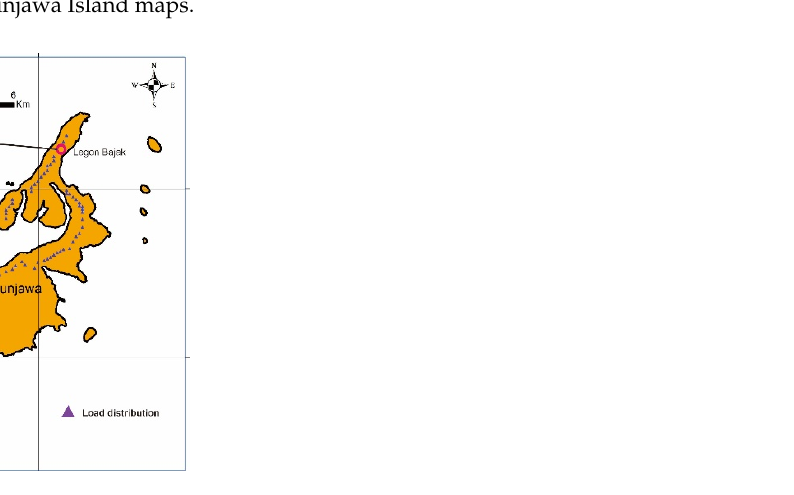
Figure 3. The location of the DPP system and load distribution on the island of Karimunjawa.